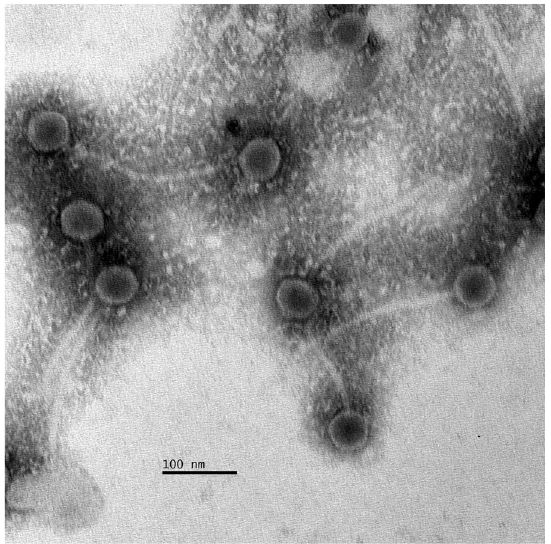
Figure 1. Electron micrograph of the phage PLg-TB25 induced from strain